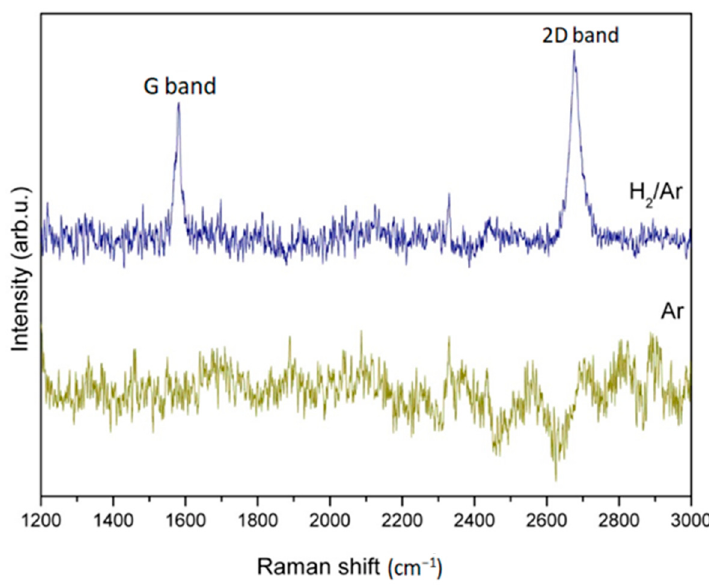
Figure 11. Raman spectroscopy pattern of the graphene grown on copper foil substrates after optimal graphene growth with pretreatment atmosphere of H 2 /Ar or Ar compositions, respectively.